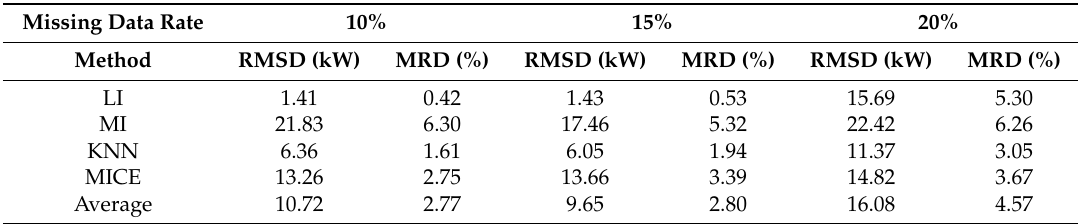
Table 7. Deviation of missing data imputation from the PV forecasting model with test data in June. Missing Data Rate Missing Data Method LI